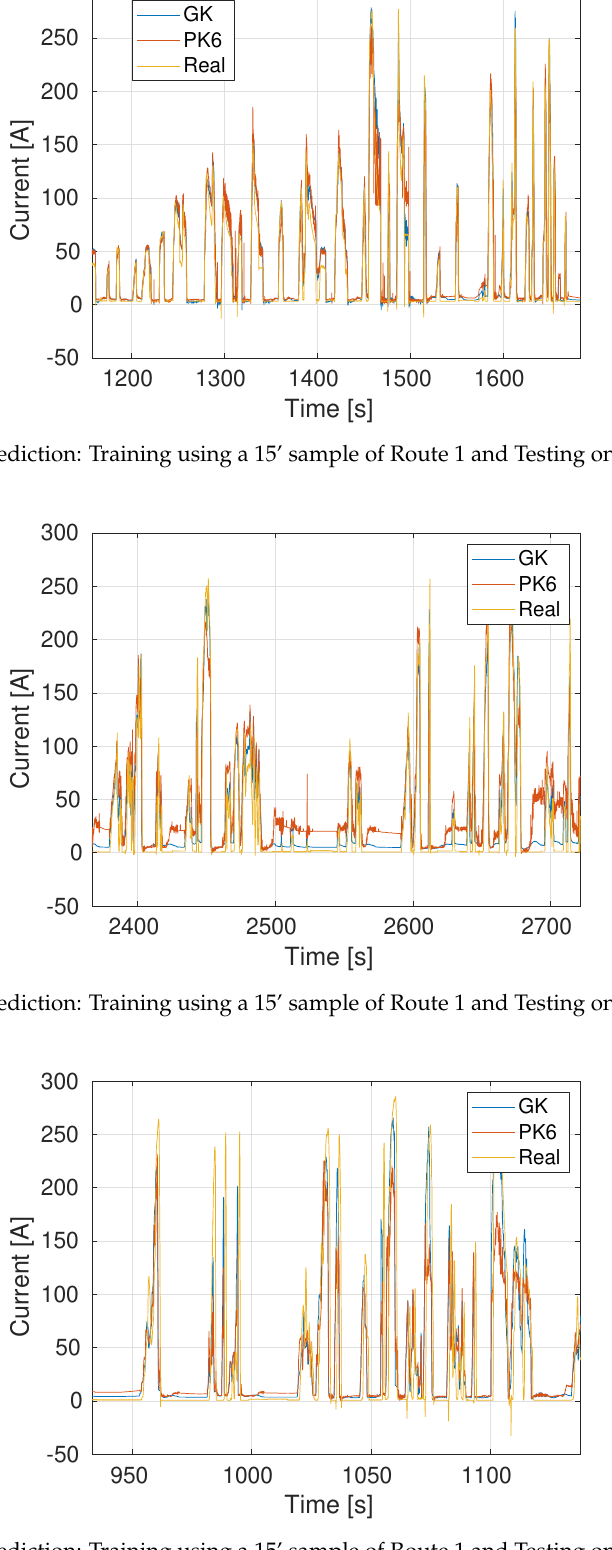
Figure 7. Current prediction: Training using a 15’ sample of Route 1 and Testing on a small portion of Route